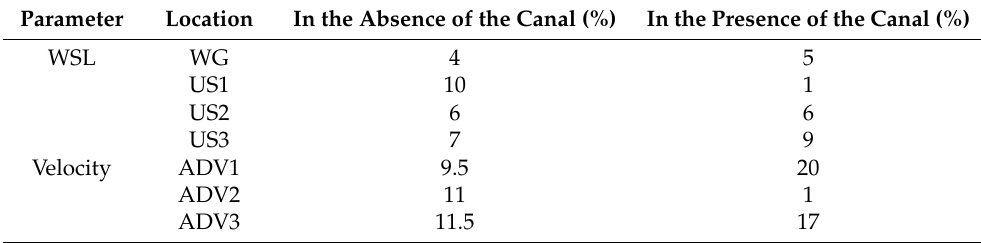
Table 2. Percentage error values of the compared numerical results versus laboratory measurements of the maximum water surface levels and velocities. Parameter